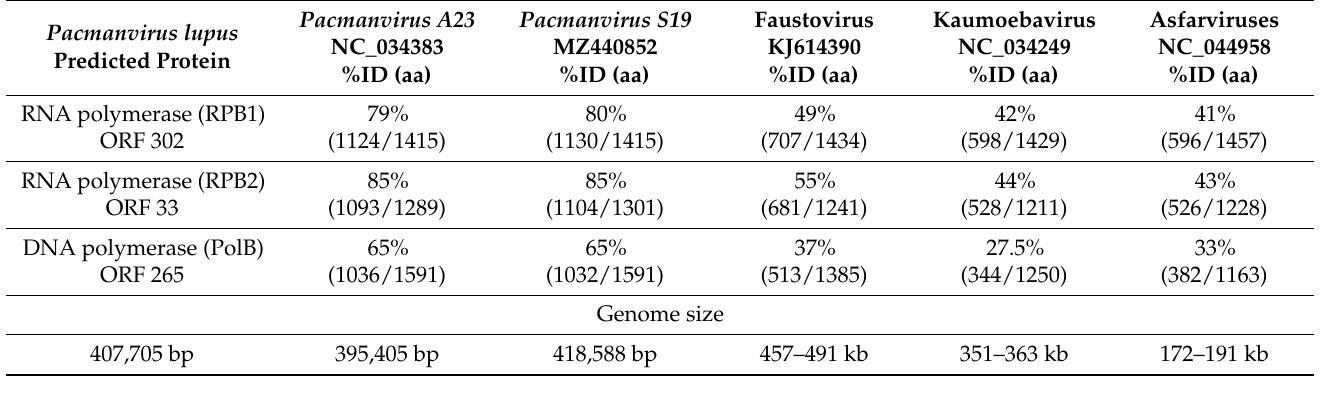
Table 7. Closest virus relatives of Pacmanvirus lupus.